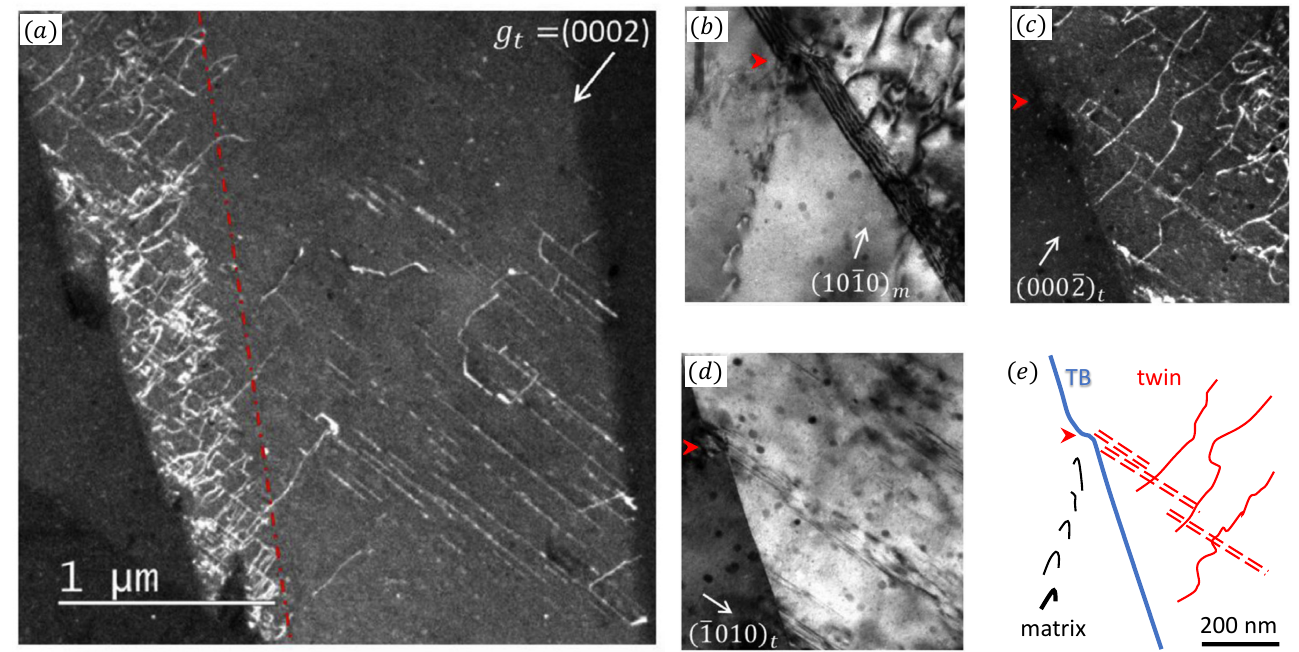
Figure 3. TEM observations showing ( a ) abundant dislocations inside a twin along twin boundary (TB); ( b ) train of dislocations on basal plane potentially piling up across TB at a point shown by red arrow; ( c ) dislocations inside twin visible with diffraction vector g = ( 00 02 ) ; and ( d ) I 1 and I 2 stacking faults. ( e ) shows all the features in a schematic, where curved lines represents dislocations and dashed lines represent stacking faults reproduced from [66], with permission from Elsevier